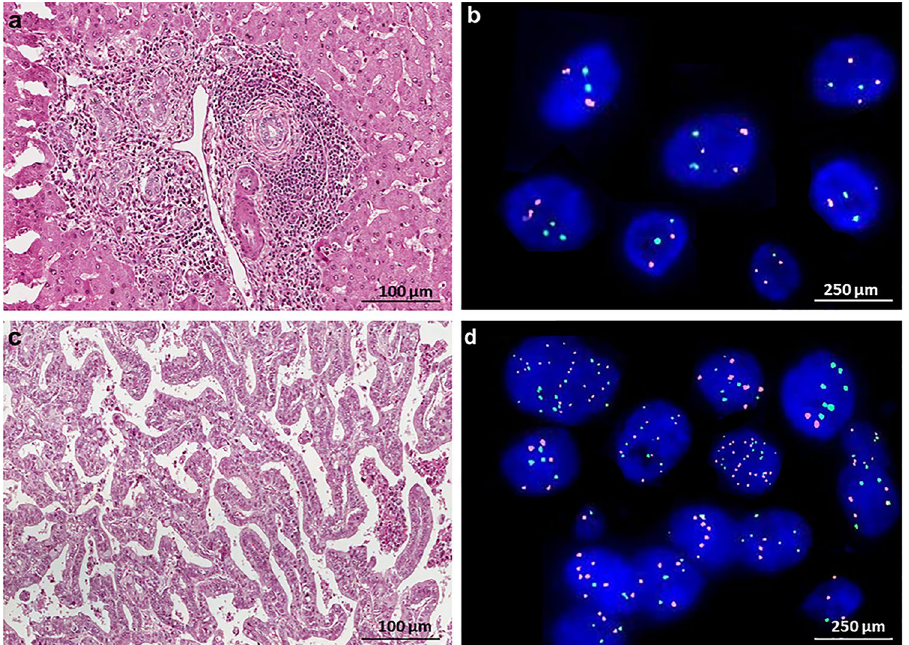
Figure 2. The representative figures of chromosomal aberrations in CCA and cholangitis patients. FFPE from a cholangitis patient; H&E staining, 400X, scale bar = 100 µm ( a ) showed disomy C7 and 17 of FISH assay,